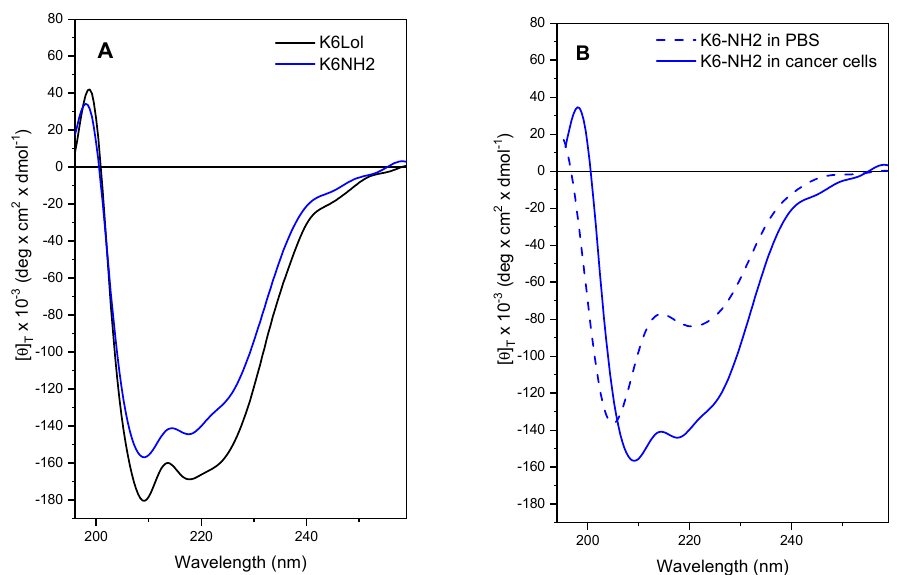
Figure 9. Circular dichroism profiles of K6-Lol and K6-NH2 in the presence of cancer cells. ( A ) L-428 cells were treated with peptaibols and the peptide 3D structure was analyzed by CD. The two peptaibols adopt a stable helical conformation (peptide concentration: 10 µM). ( B ) Comparison between the CD profiles acquired for K6-NH2 in the presence (full line) or absence (dashed line) of cancer cells. The increase in the intensity of the band at about 220 nm for the peptide in the presence of cancer cells (panel B, full line) is indicative of the onset of peptide aggregation in cancer cells and not in PBS buffer alone.